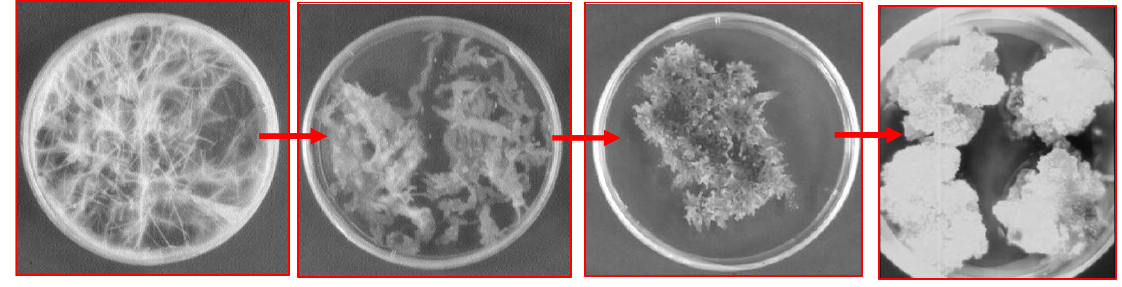
Figure 7 . Dedifferentiation of tobacco hairy roots by subculturing in hormone- supplemented MS